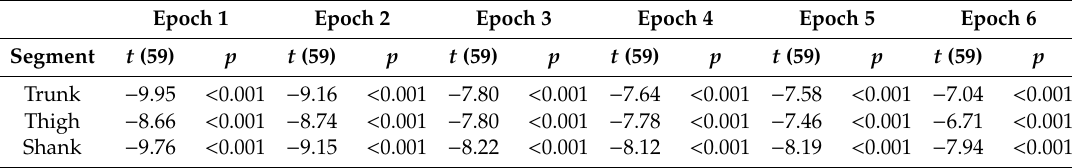
Figure 3. EMG integrals of ES and TA calculated for the sliding conditions (white) and fixed conditions (black) are shown for each epoch. * represents statistical significance ( p < 0.05) of the factor of sliding board and ** for p < 0.001. Table 2. The results of paired-samples t -test for the trunk, thigh, and shank segments in Epoch 1 to Epoch 6 .